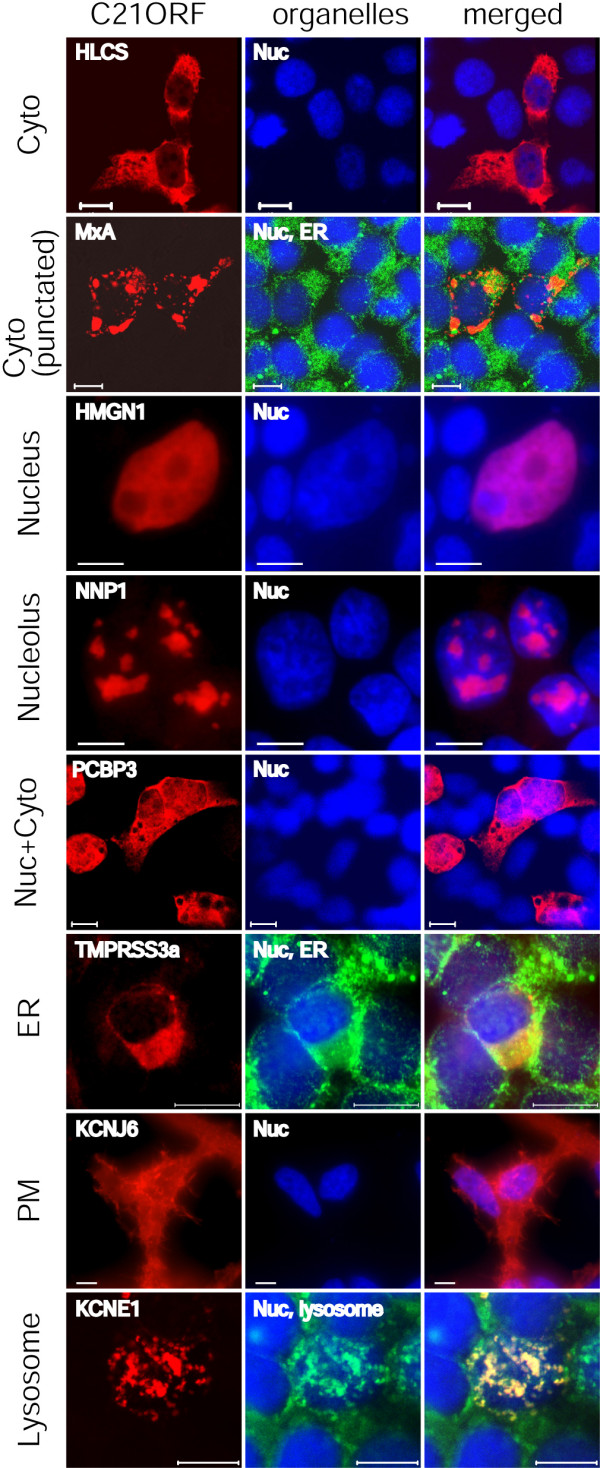
Localization categories for detected chromosome 21 (Chr21) proteins. The Chr21 proteins were localized in a variety of cellular compartments. The images in the left panel represent anti-His staining of Chr21 proteins, with the gene names indicated in the upper left corner of each image. The images in the middle panel show applied counterstaining, with organelles indicated in the upper left corner. The images in the right panel present a merged picture from detection of Ch21 proteins and counterstaining. The scale bar represents 10 μm.